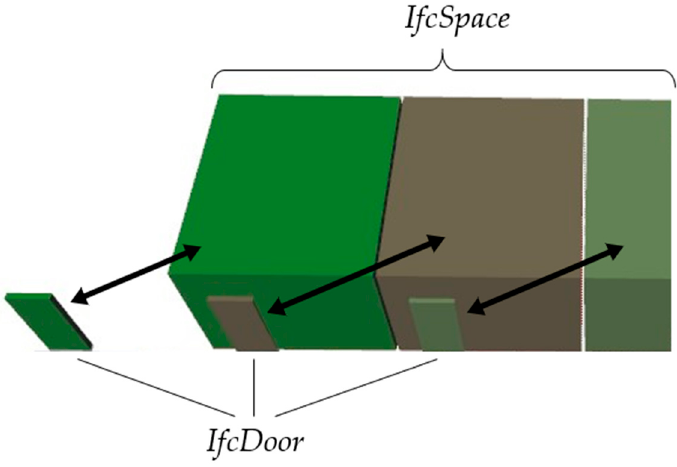
Figure 13. Errors in IfcSpace and IfcDoor (having equal colour) relations retrieved from the IfcRelSpaceBoundary entity.